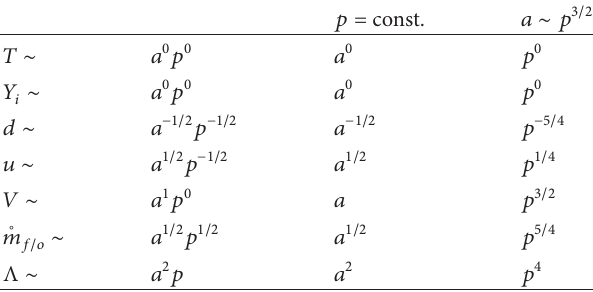
Table 1: Overview over the magnitude scaling parameters. 𝑝 = const.